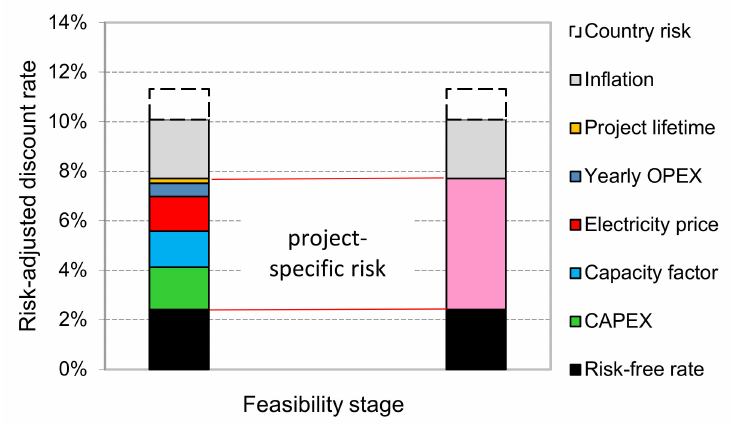
Figure 3. Key risk components of the risk-adjusted discount rate for Polish onshore wind projects at the feasibility